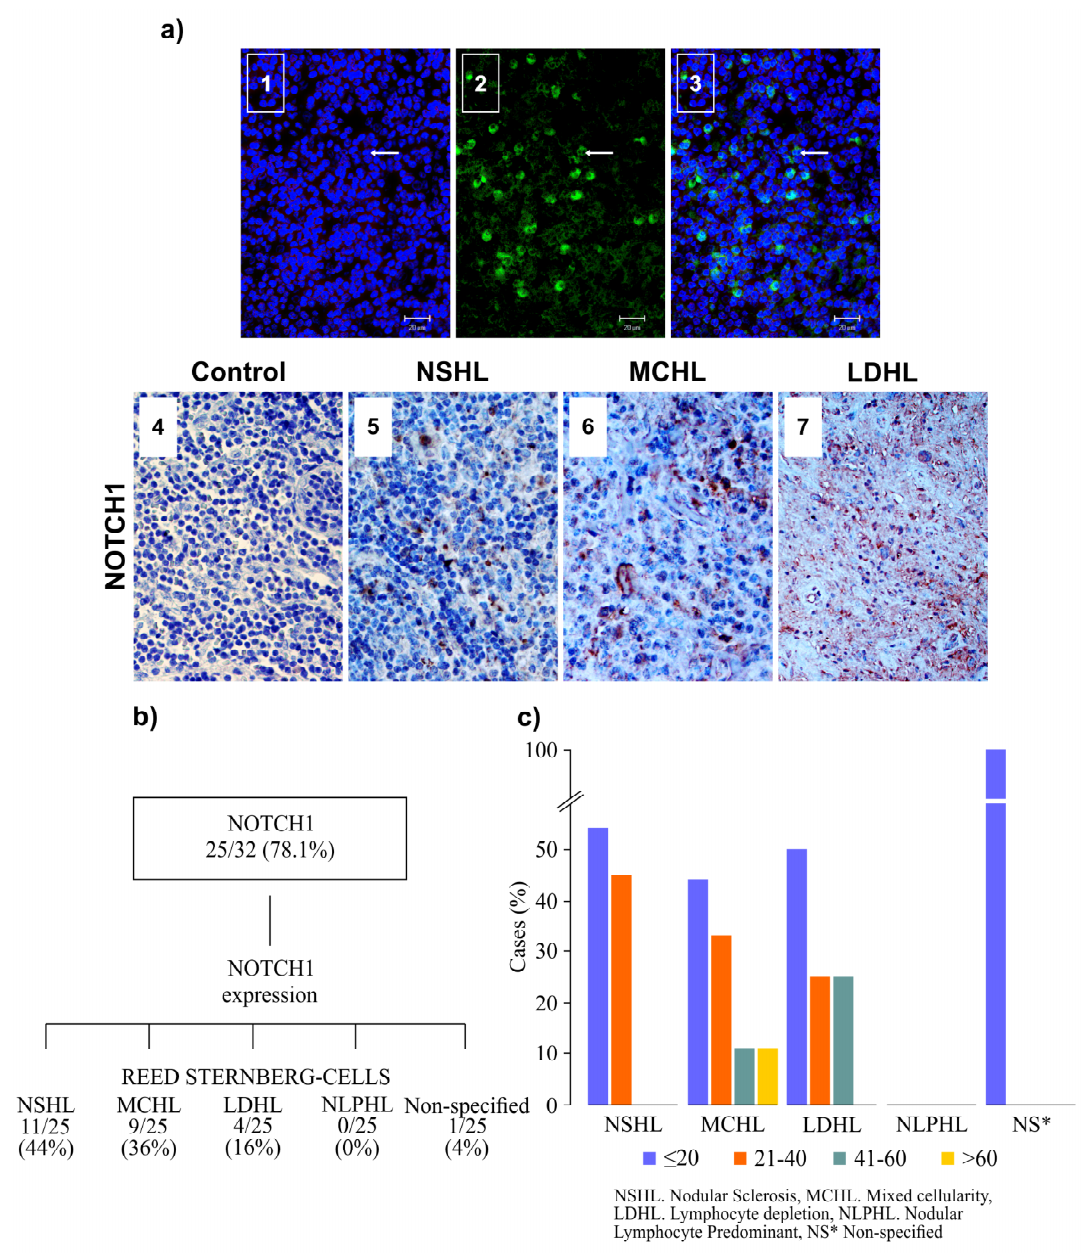
Figure 2. NOTCH1 expression in cHL is shown. ( a ) Immunoreactivity for NOTCH1 by multi-channel fluorescence microscopy automated image system (Applied Imaging Co.) (1–3) and by immunohisto chemistry (4–7). 1. Confocal analysis labeling of cHL nuclei by DRAQ7TM (blue) in a case of NSHL; 2. NOTCH1 labeling with fluorescein, arrow (green); 3. Merge of nuclei and immunoreactivity for NOTCH1; (4–7) Immunohistochemistry for automated image system (Applied Imaging Co.): 4. Negative control for NOTCH1; 5. Immunoreactivity for NOTCH1 in NSHL; 6. Immunoreactivity for NOTCH1 in MCHL; 7. Immunoreactivity for NOTCH1 in LDHL (original magnification × 400: bars 20 µ m). ( b ) Graph showing a number of cases identified with the different types of cHL positive for NOTCH1 immunoreactivity. ( c ) The graph shows the percentage of cases that expressed NOTCH1 in the different types of cHL and the range of Reed–Sternberg cells (RSCs) positive for NOTCH1 by immunohistochemistry in paraffin-embedded